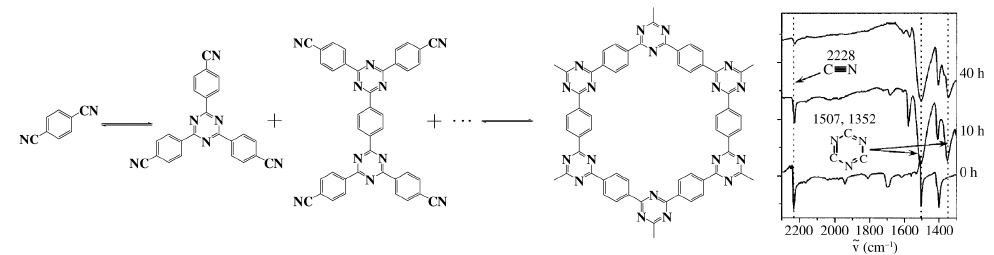
Figure 2: Trimerization of dicyanobenzene in molten ZnCl based framework (CTF-1) (Kuhn, Antonietti, and Thomas 2008), and FT-IR spectra following the progress of the conden- sation.